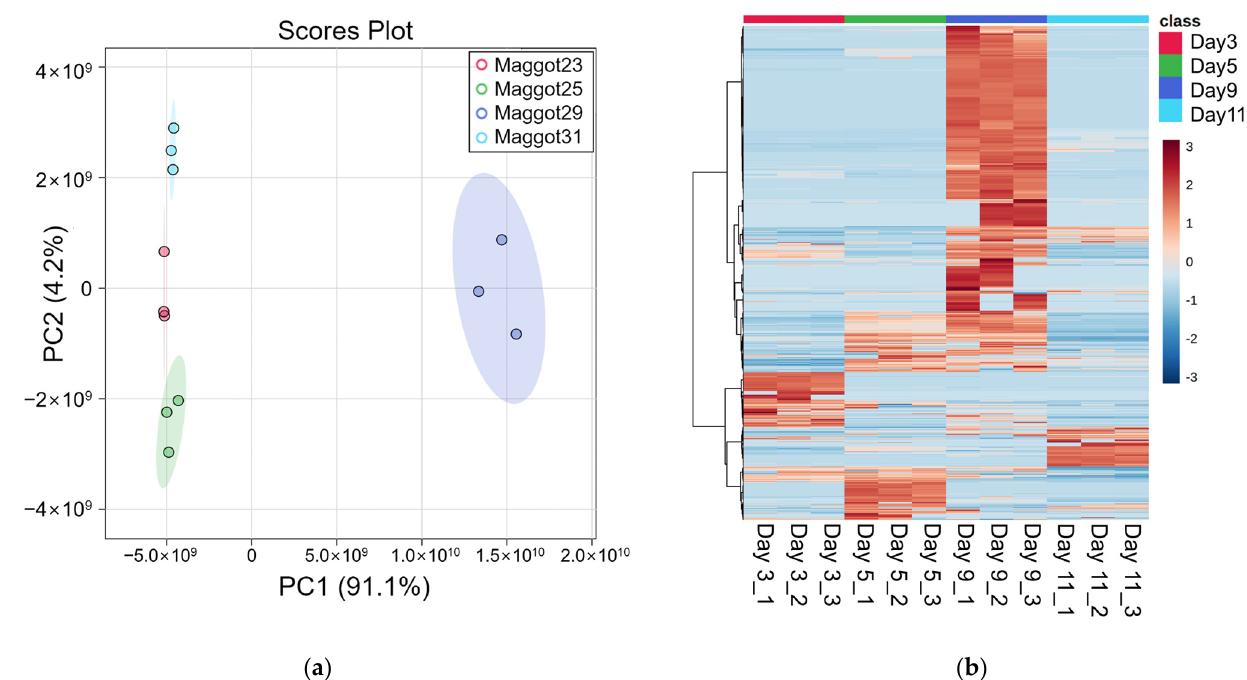
Figure 2. Metabolomics analysis results. ( a ) PCA plot, ( b )